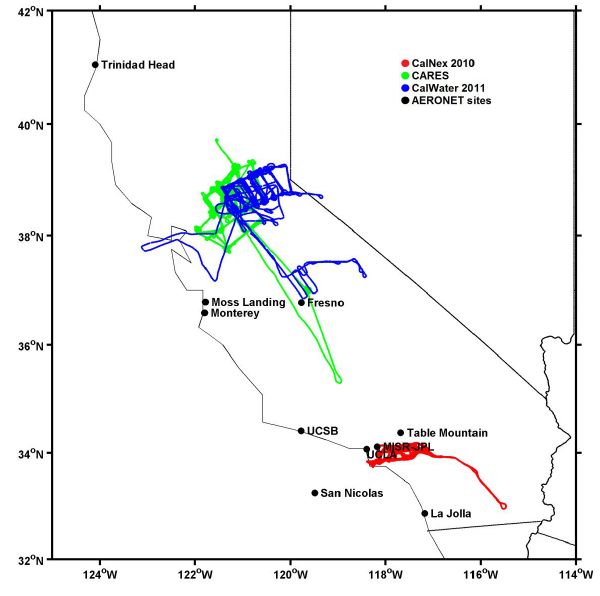
Fig. 1. Map of California with the flight paths of the aircraft cam- paigns and the location of the AERONET Figure 1. Map of California with the flight paths of the aircraft campaigns and the location of the 3 AERONET stations. 4